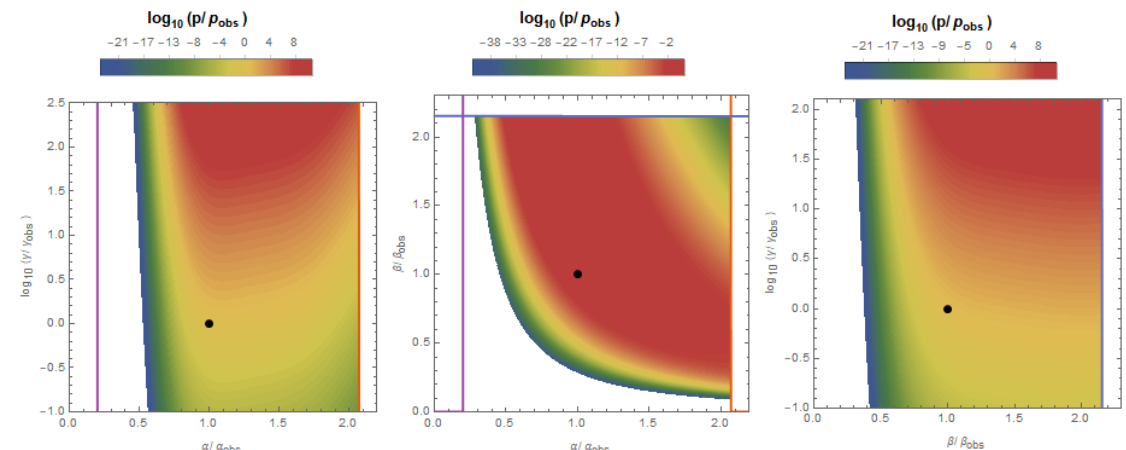
Figure 2. The distribution of observers if life can only arise on a terrestrial planet in the α – γ , α – β , and β – γ subplanes, size being dictated by a giant impact phase. Here, we have used a log-normal {? distribution with σ “ 1 6, excluded λ dependence on the average planet mass, and assumed accretion dominated